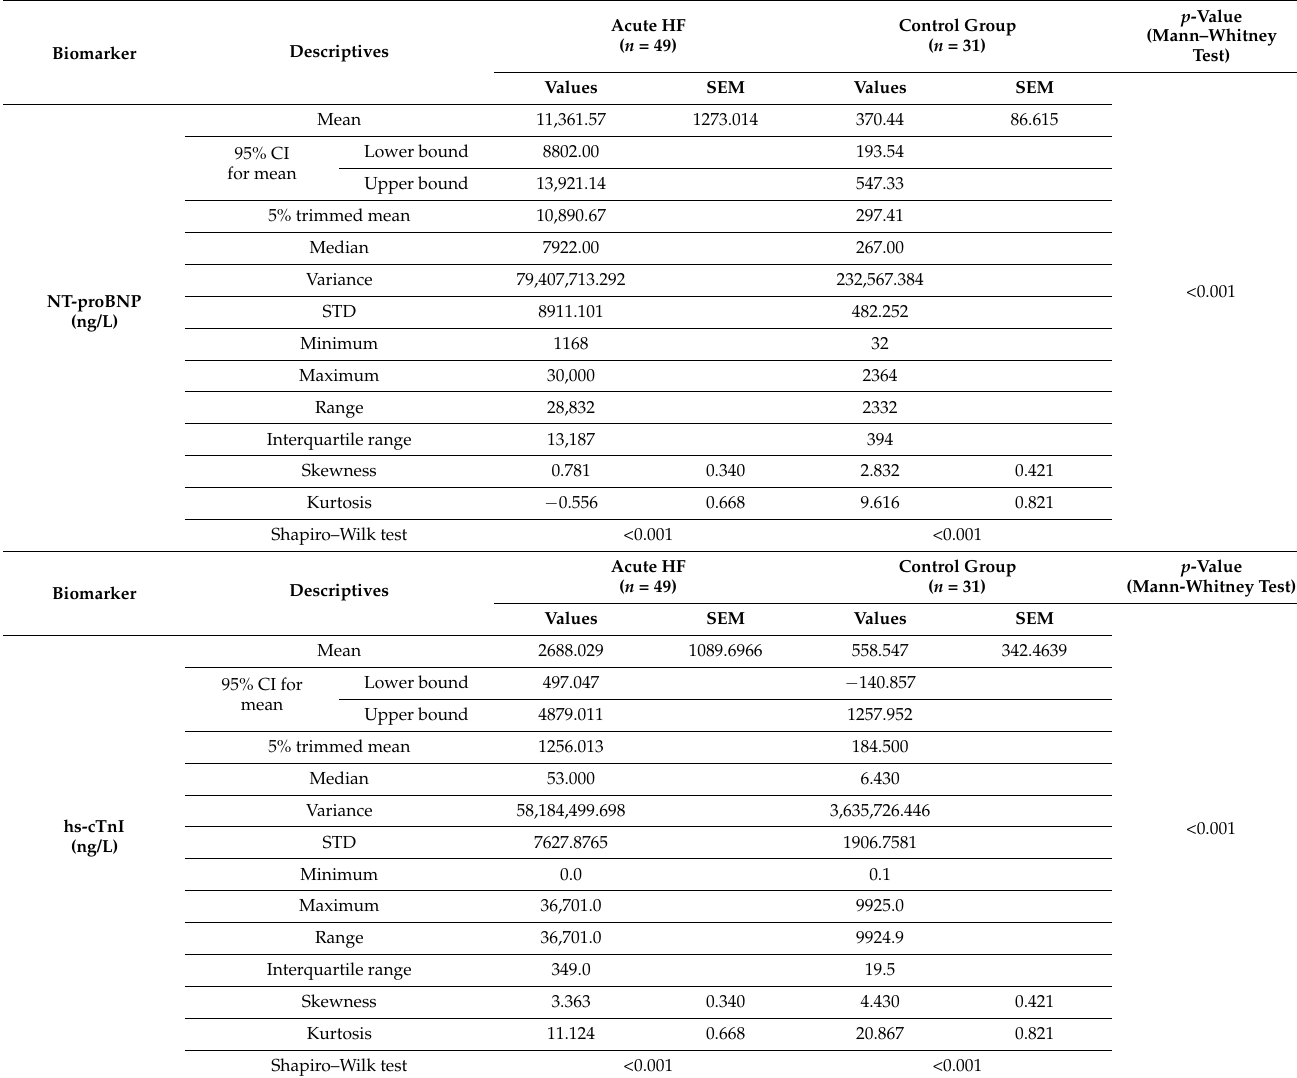
Table 6. Cardiac biomarkers profile in acute HF and control